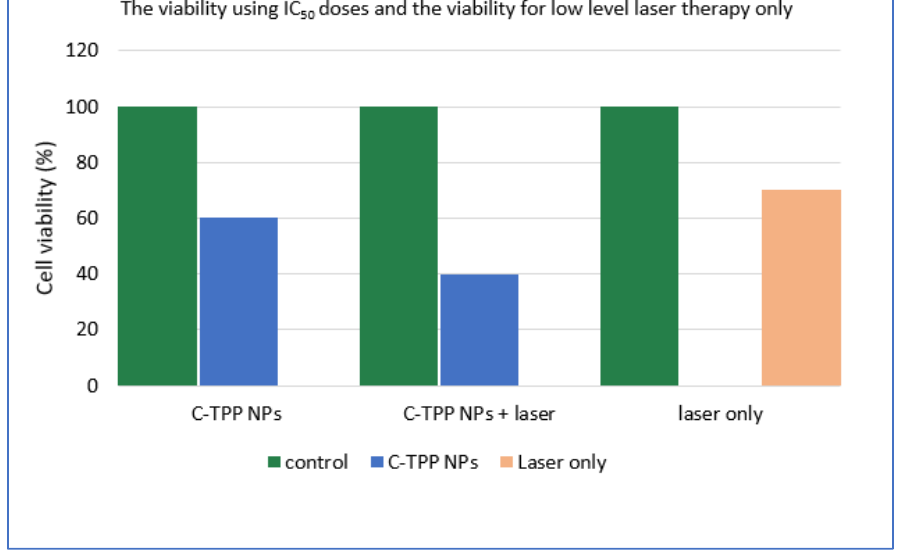
Figure 4. The activity of the C-TPP NPs against Caco 2 cells in the presence and the absence NIR. The cell viability against low level laser therapy only.